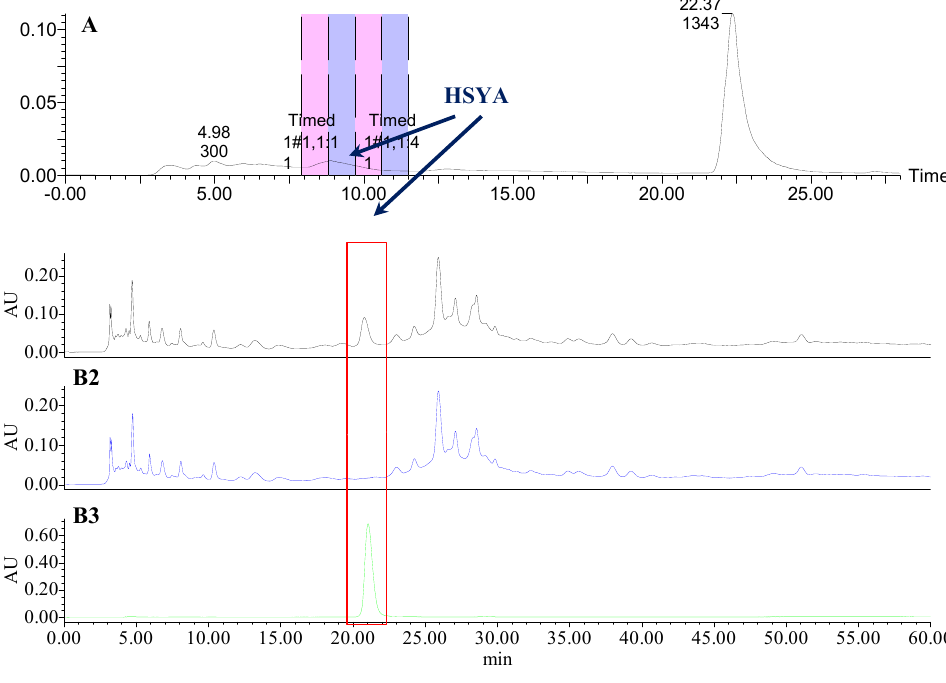
Figure 6. The preparative and analytical chromatograms of the depletion of HSYA from CF-SL; ( A ) preparative chromatogram at 270 nm; ( B1 ) analytical chromatogram of CF-SL at 270 nm; ( B2 ) analytical chromatogram of CF-SL-A at 270 nm; ( B3 ) analytical chromatogram of HSYA depleted from CF-SL at 270